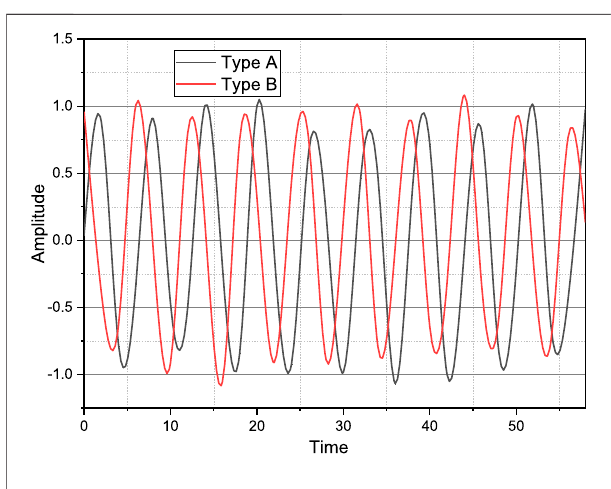
FIGURE 2 | Input-level ESD circuit diagram.